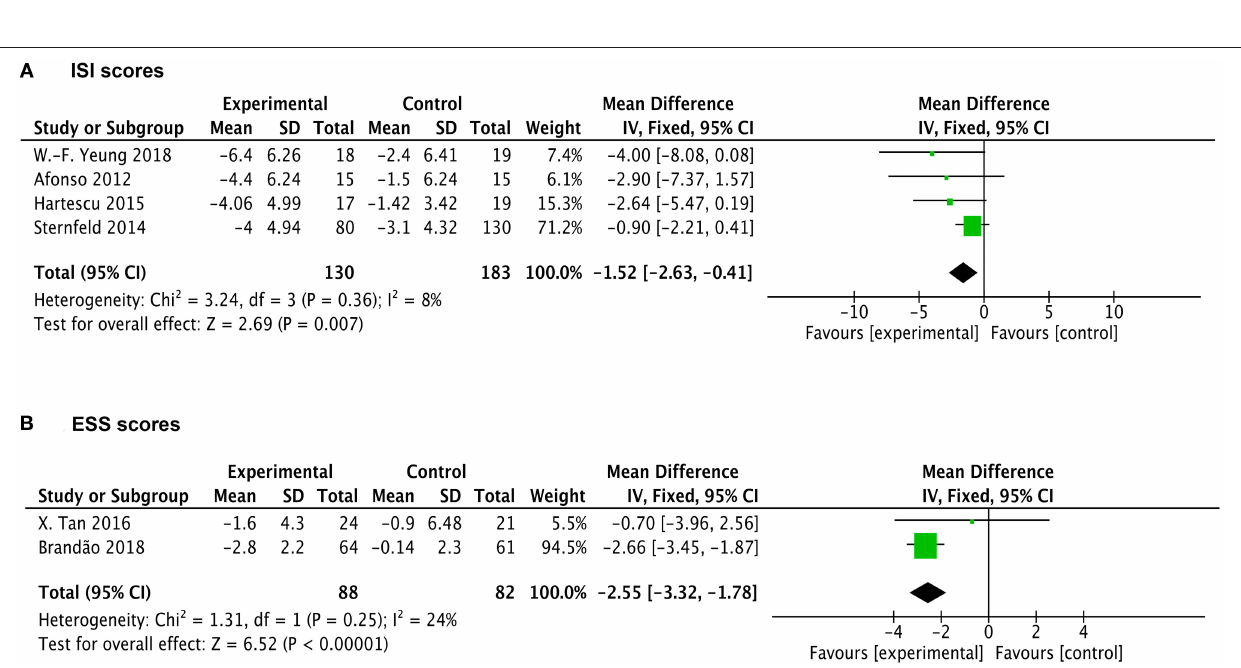
sleep disturbance ( Figure 3 , Table 2 ). There was no significant difference of enhancing effects between physical exercise and mind–body exercise ( p =